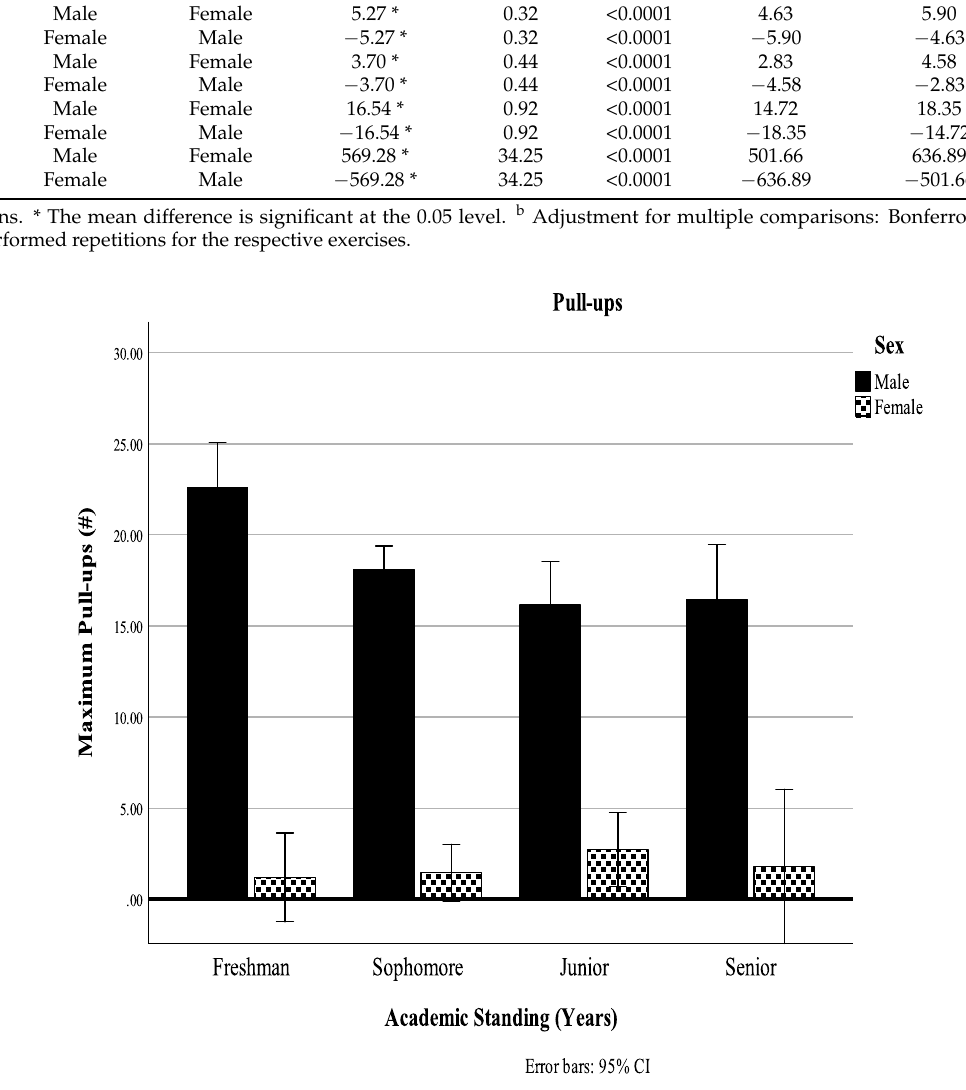
Figure 1. Pull-ups Academic Years by Sex Interaction. # Denotes number of performed repetitions for the respective exercises.